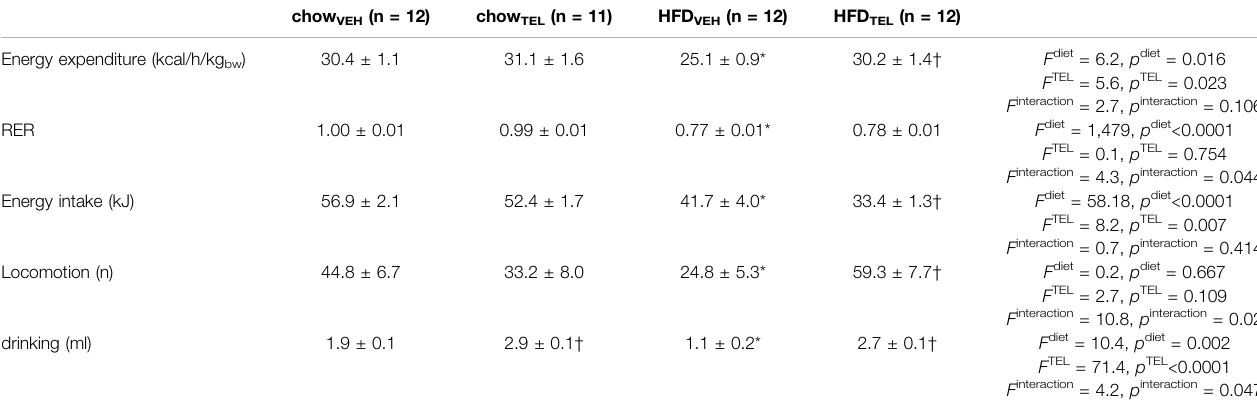
TABLE 3 | Energy expenditure, energy intake, drinking, respiratory ratio and locomotion during dark periods of chow and HFD-fed mice which were treated with vehicle or TEL. 2-way ANOVA was calculated considering diet and treatment followed by Sidaks multiple comparisons test. means ± SD, * p < 0.05 vs. chow VEH , † p < 0.05 vs. corresponding vehicle